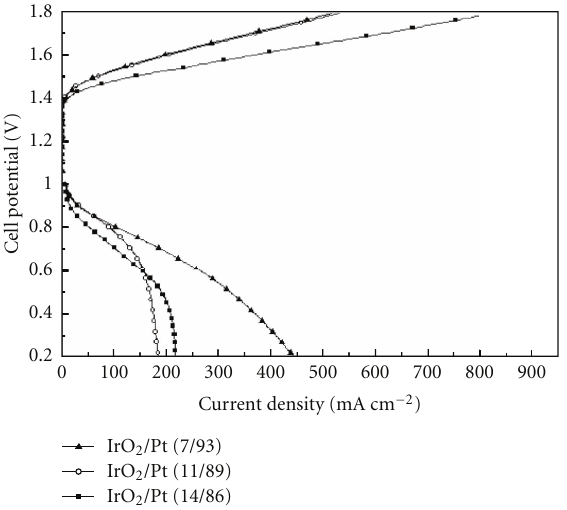
Figure 3: Cell potential versus current density curves for MEAs based on IrO 2 /Pt catalysts at di ff erent compositions (7/93, 11/89, and 14/86) under URFC conditions.